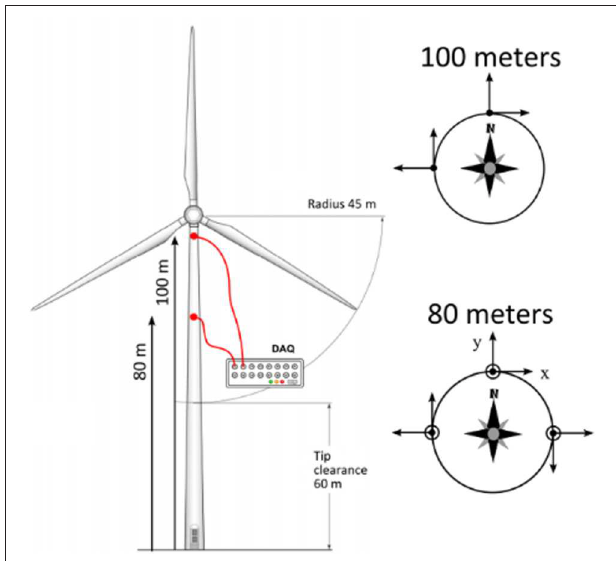
FIGURE 4 | Wind turbine tower and sensor instrumentation set-up (Chatzia and Spiridonakos, 2015